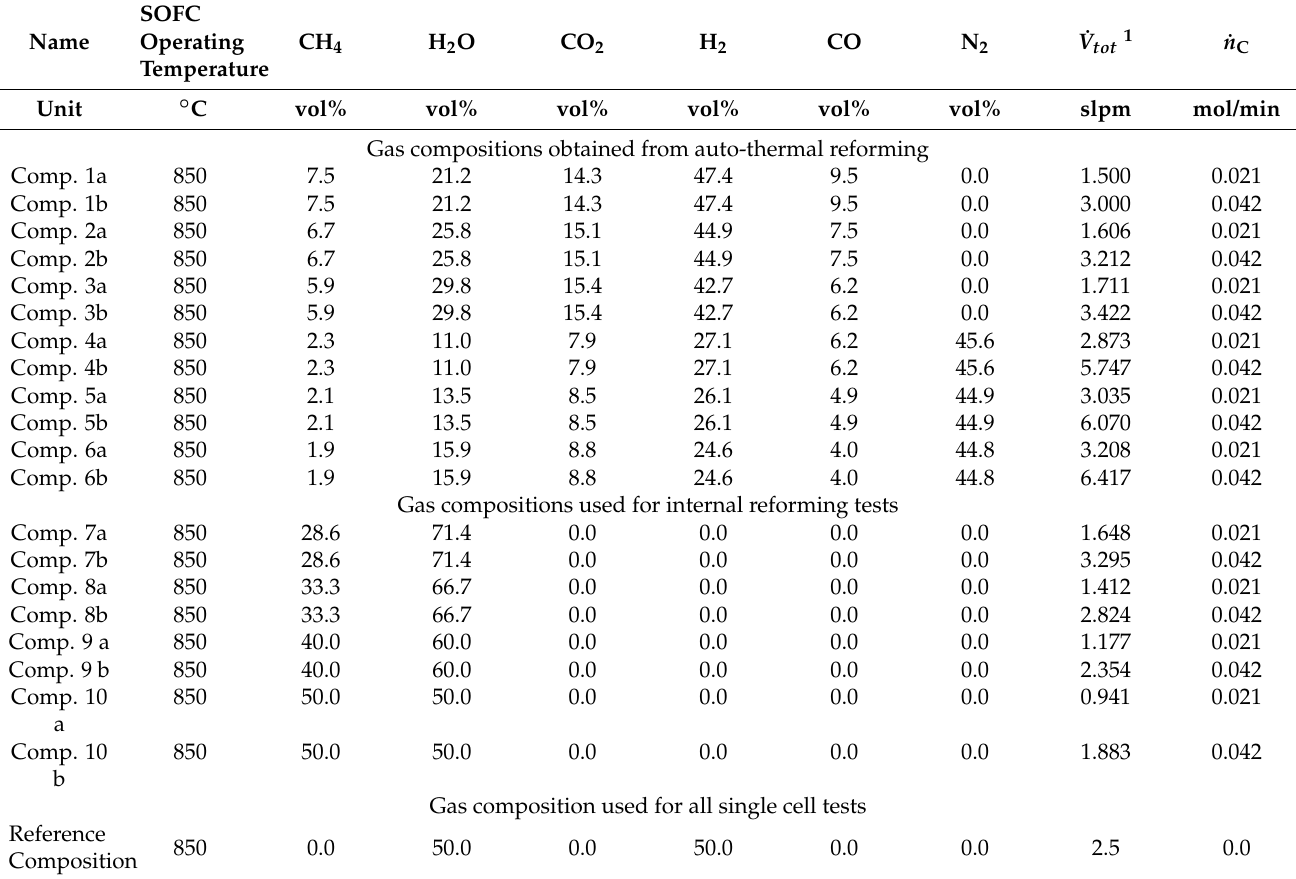
Table 3. Inlet gas compositions for the single cell